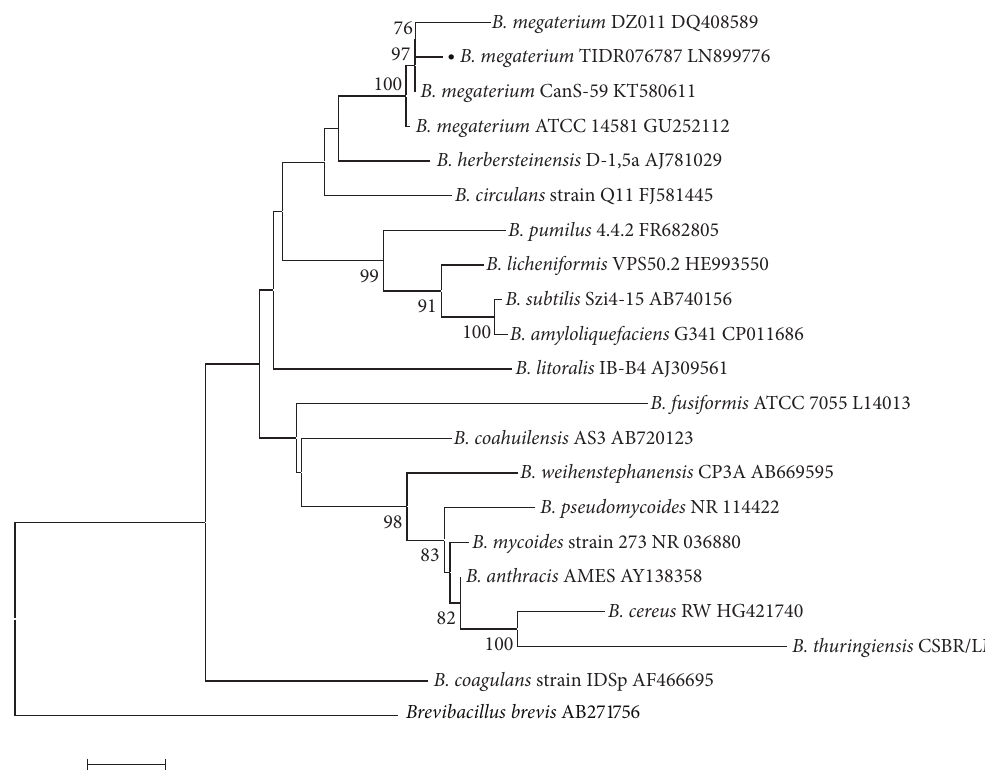
Figure 1: Neighbor-joining phylogenetic tree of representative Bacillus spp. The B. megaterium isolate obtained in the present study is indicated by a solid black circle before its name. Accession numbers are indicated after the respective Bacillus spp. names. Brevibacillus brevis was used as an outgroup. Numbers at nodes indicate bootstrap values (%) for 1,000 replicates. The scale bar indicates nucleotide substitutions per site.